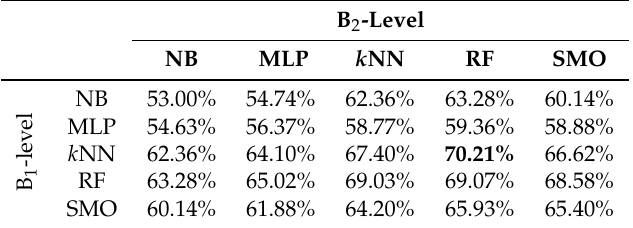
Table 7. Two-level classifier classification using SMO as A-level classifier.